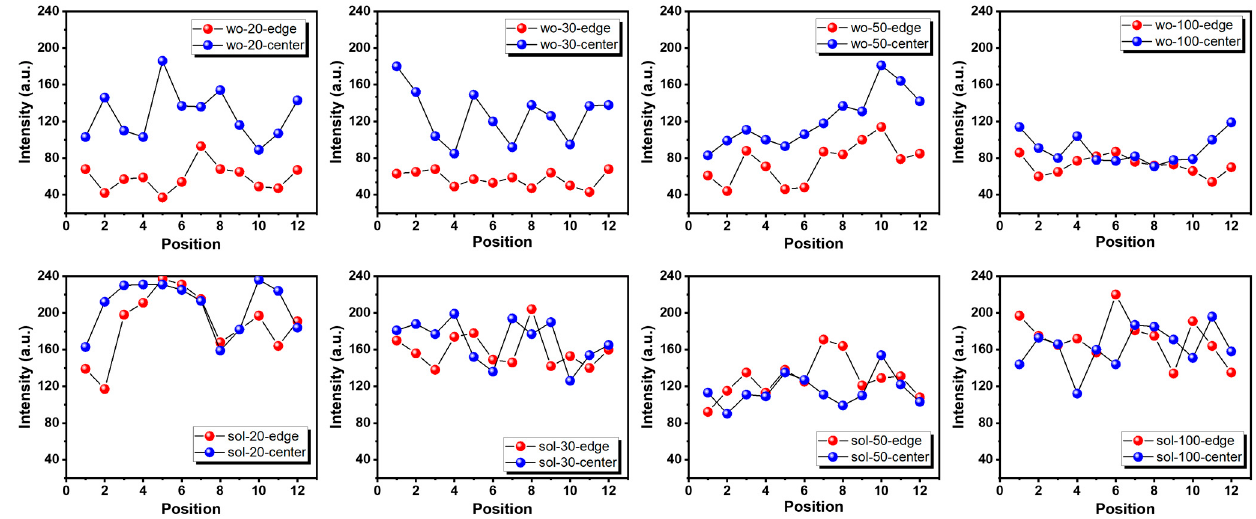
Figure 3. Intensity distribution of edge (red dot) and center (blue dot) emission of different sizes with different passivation.